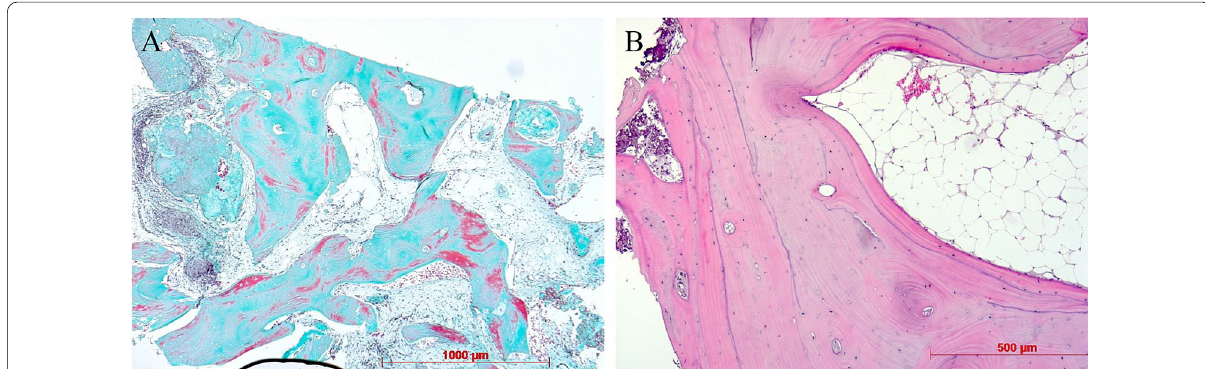
Fig. 9 Newly formed cancellous bone, intertrabecular loose connective tissue, trichrome staining, original magnification cancellous lamellar bone, HE staining, original magnification